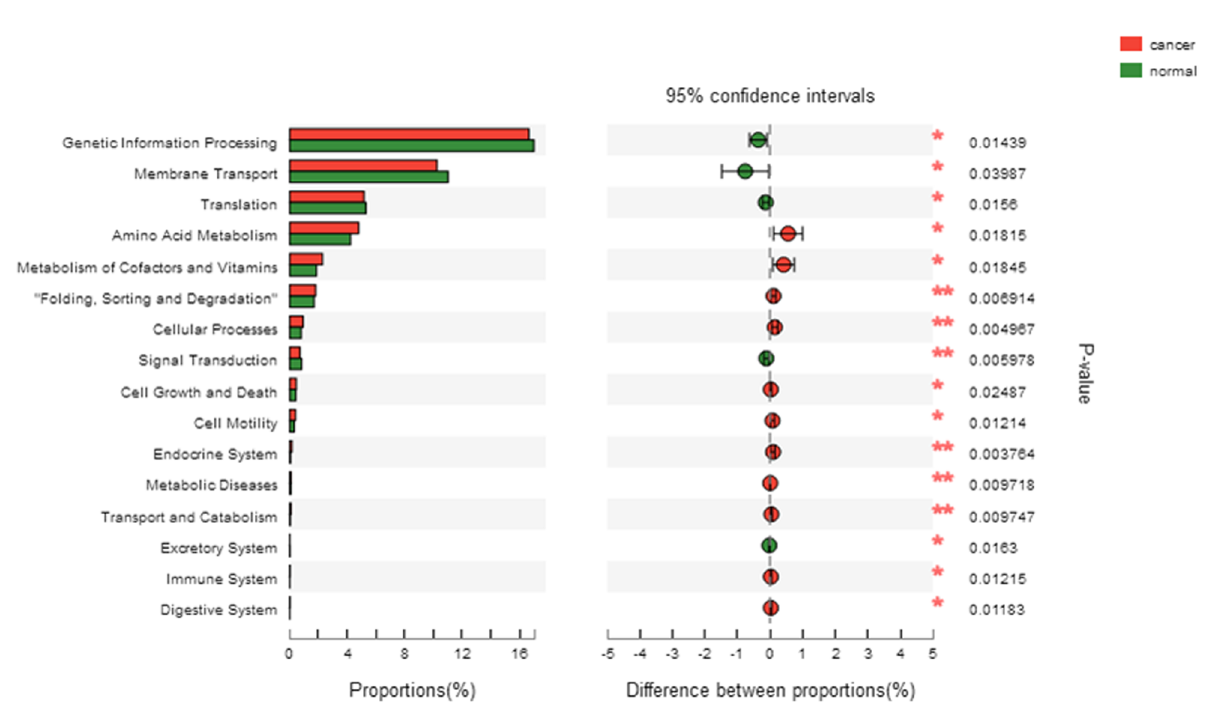
Figure 5 - PICRUSt infers the cellular functions of bacterial communities in cervical cancer.